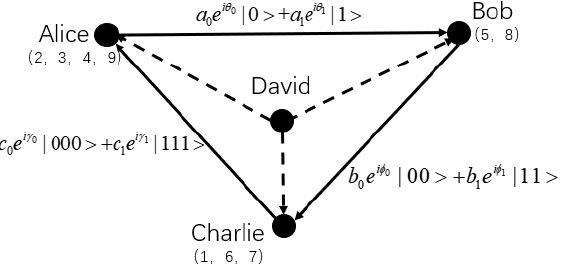
Figure 1. The schematic of the four-party cyclic asymmetric remote state preparation (RSP) protocol. The black arrow points out the direction of the communications and the dashed line represents the control